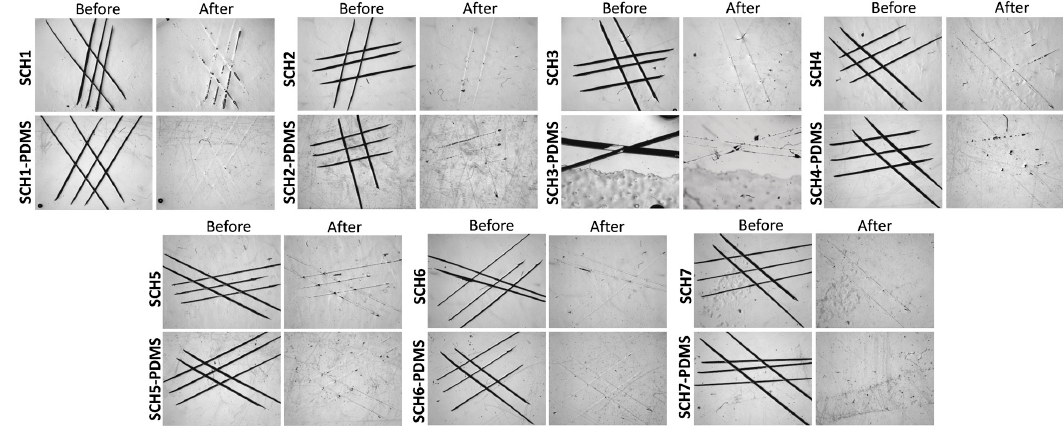
Figure 5. Optical microscopy images showing the self-healing capabilities of various PU with and without PDMS coatings both before and after thermal treatment at 130 °C for 40 min.